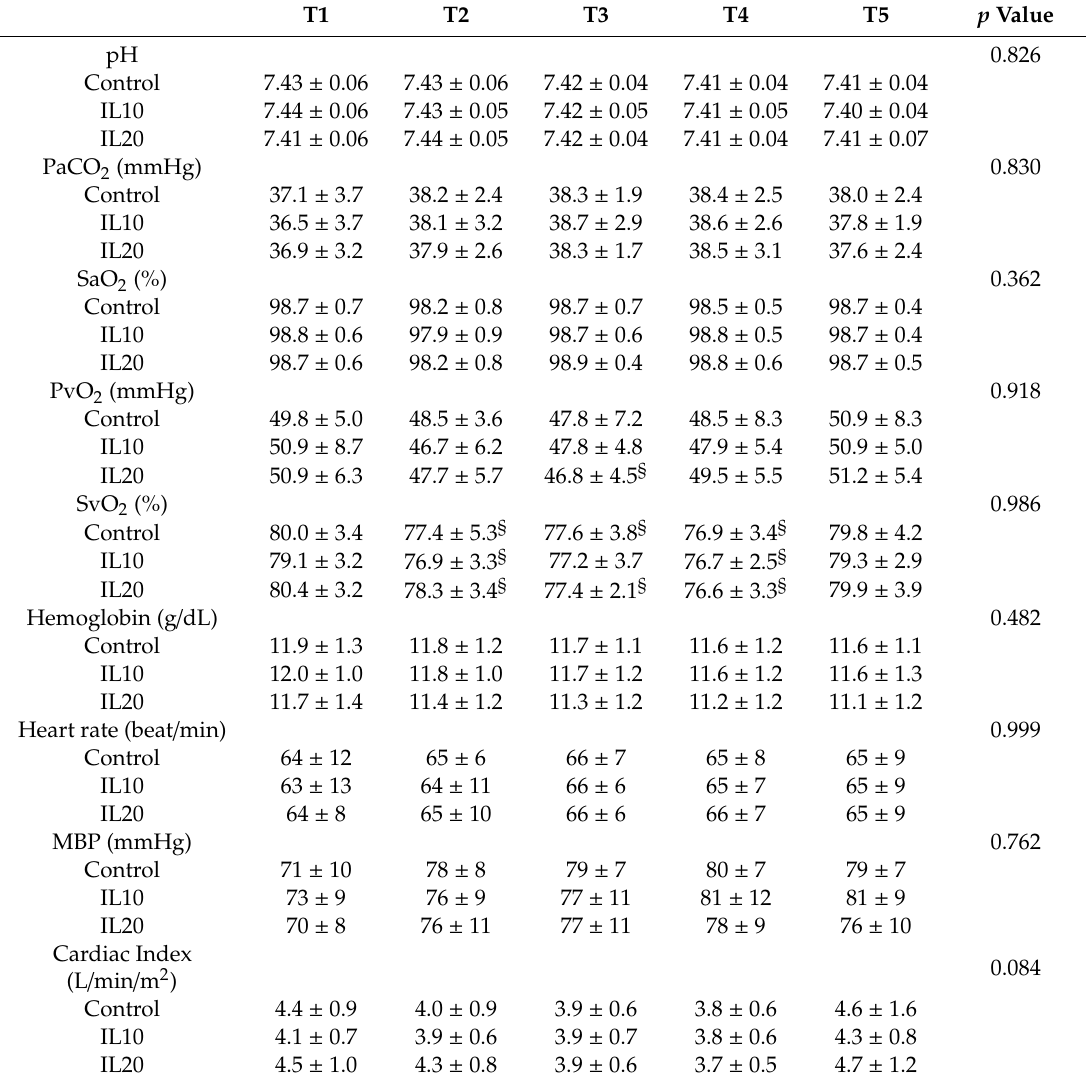
Table 3. Arterial / vein blood gas and hemodynamic